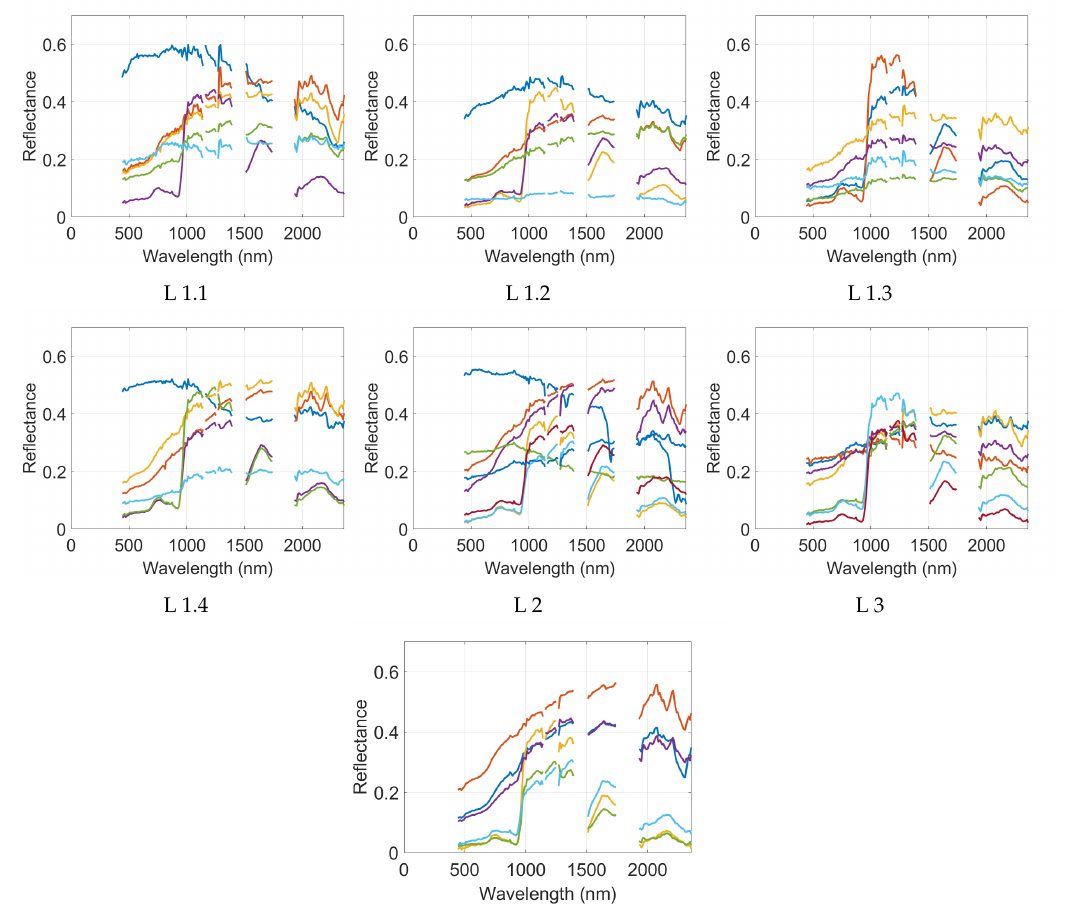
Figure 14. Endmembers for each leaf tile in the Urban quadtree.